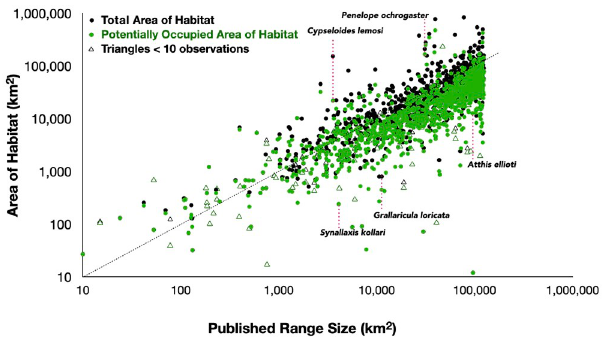
Fig 3. Area of Habitat and Potentially Occupied Area of Habitat versus the published range. Black symbols represent estimates of total Area of Habitat and green symbols represent Potentially Occupied Area of Habitat. Solid symbols represent species with ten or more observations, open triangles represent those with fewer than ten. The text discusses the five examples labelled. Dotted diagonal line shows identical values along the two axes.